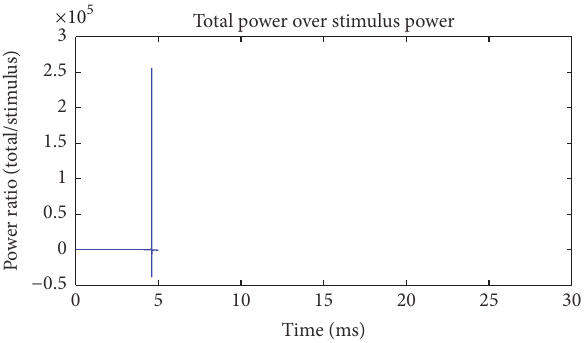
Figure 10: Subthreshold membrane potential.